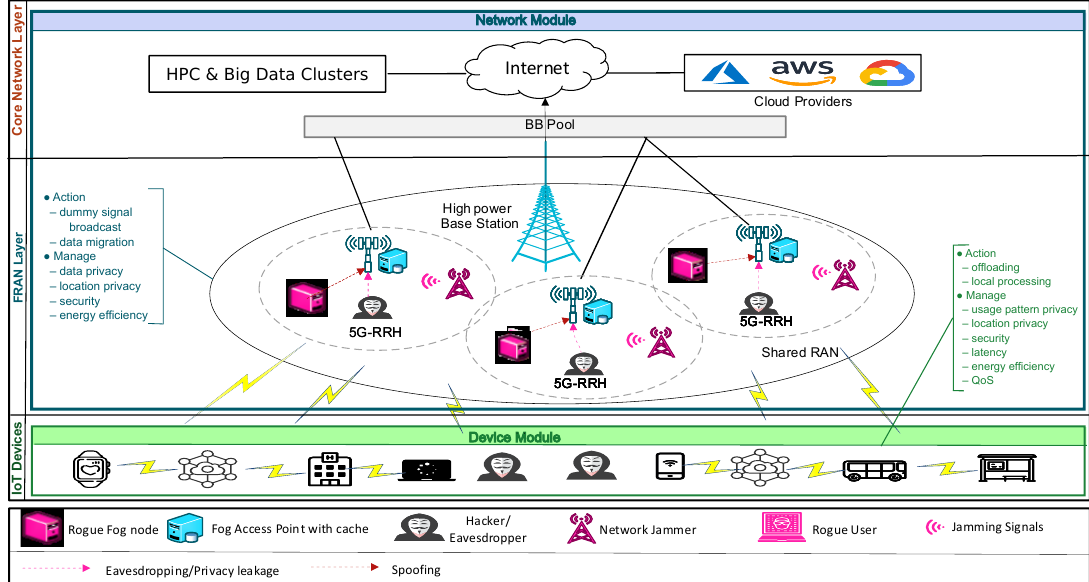
Figure 1. The network and architectural overview of